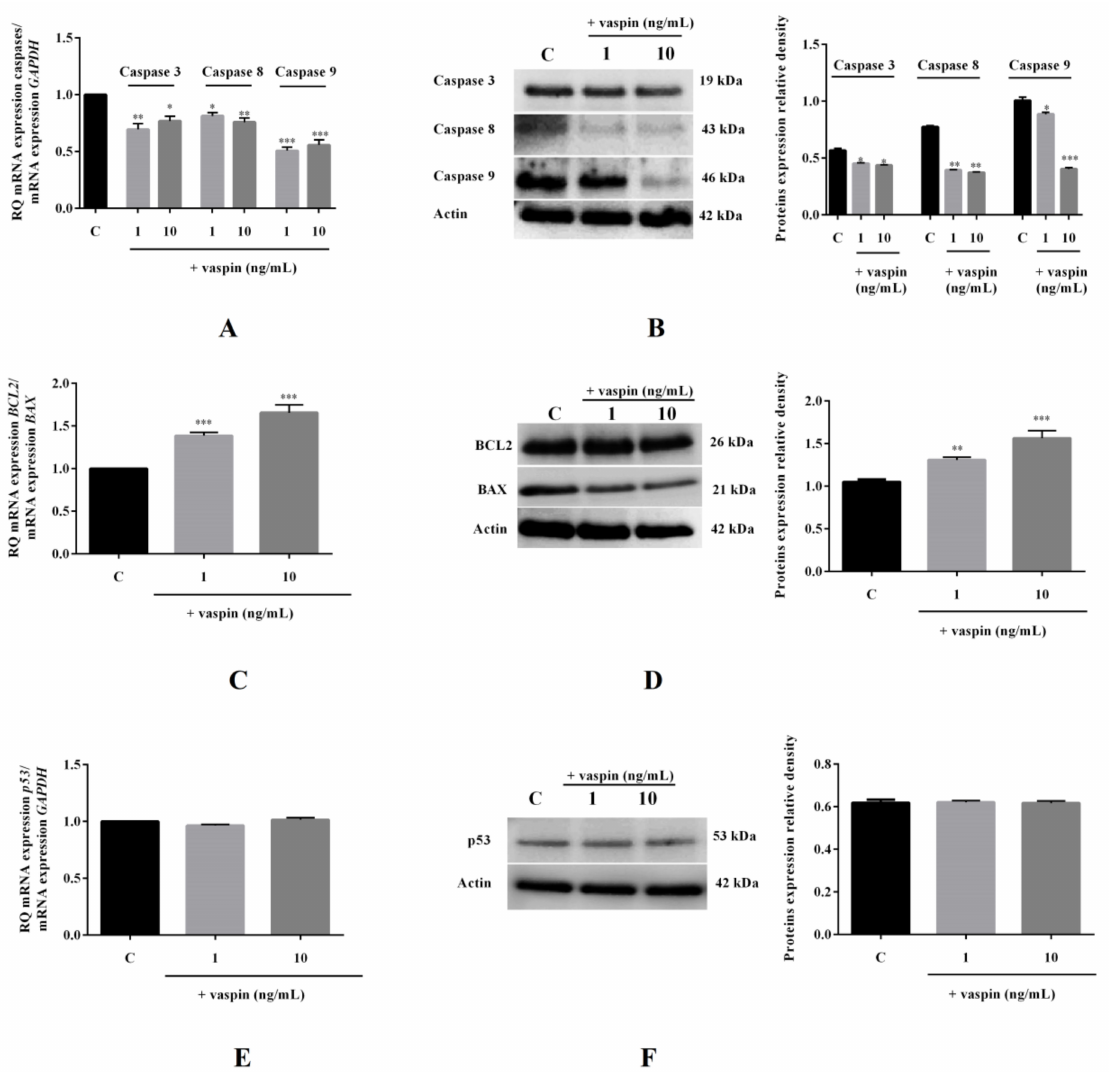
Figure 5. E ff ect of vaspin on mRNA and protein expression levels of caspase-3, -8, and -9; BAX (bcl-2-like protein 4), and BCL2 (B-cell lymphoma 2). The cells were treated with 1 and 10 ng / mL vaspin for 24 h, and then, real-time PCR and Western blot analysis were performed to determine levels of caspase-3, -8, and -9 ( A , B ); BCL2 and BAX ( C , D ); and p53 ( E , F ) (full gel images are available in the Supplementary Materials). Gene expression levels were normalised to glyceraldehyde 3-phosphate dehydrogenase ( GAPDH) , while proteins levels were normalized to actin. Experiments were independently performed and repeated five times ( n = 5). The data are plotted as the means ± SEM. Significance between control and vaspin treatments is indicated by * p < 0.05, ** p < 0.01 and *** p < 0.001; Control